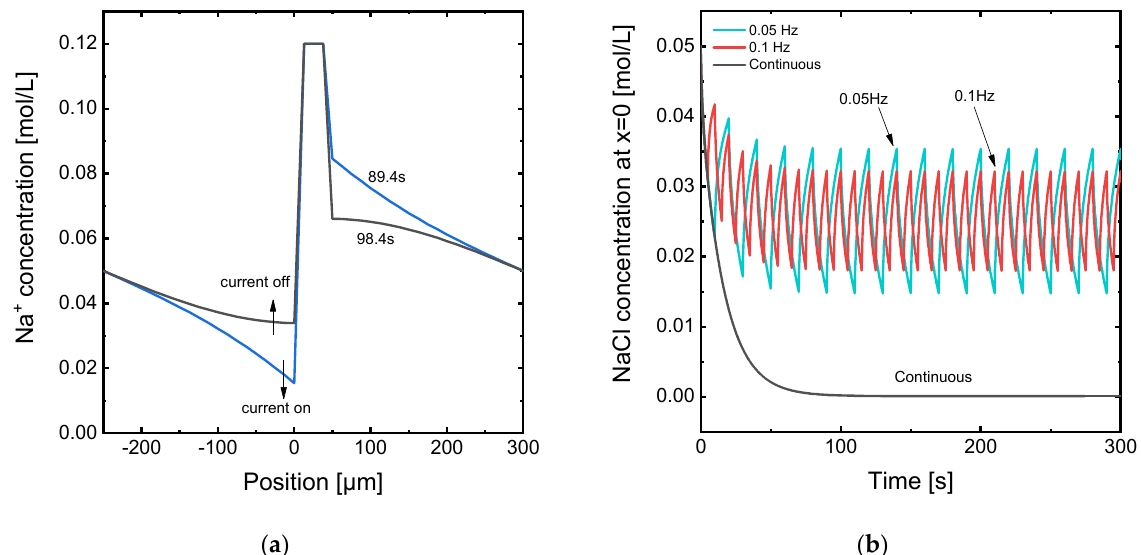
Figure 5. ( a ) Na + concentration profile along the diffusion boundary layers for the membrane system under application of i lim in pulsed electric field (PEF) mode with a pulse frequency of 0.05 Hz at different times corresponding to pulse and relaxation phases; ( b ) evolution with time of the NaCl concentration at the interface between the membrane surface and the diluting diffusion boundary layer (DBL) (position x = 0) under the application of i lim in continuous mode and in PEF mode at different frequencies. The arrows in the first plot indicate the evolution of concentration profiles during the pulses and relaxation